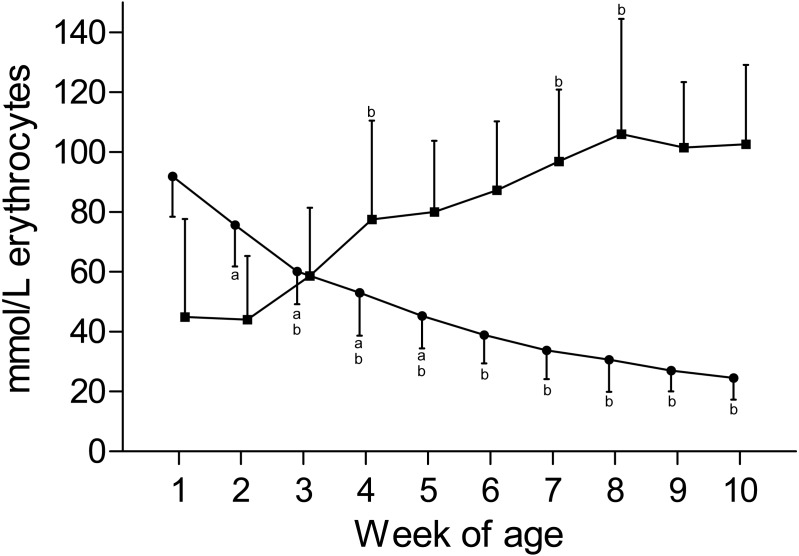
Erythrocyte potassium and sodium concentration in Holstein-Friesian calves over the course of the first 10 weeks of age.Mean (+SD) KERY (closed circles) and NaERY (closed squares) in 30 Holstein-Friesian calves over the course of the first 10 weeks of age (for both: n = 30 except for weeks 4, 6 and 9 with n = 29, week 3 with n = 28; for NaERY: week 1 with n = 26). Values marked with the superscript letter “a” differ significantly (P < 0.05) from the value of the preceeding week, whereas a “b” indicates a difference to the value of two weeks before. Values for NaERY and KERY are slightly offset for better readability of the graph.